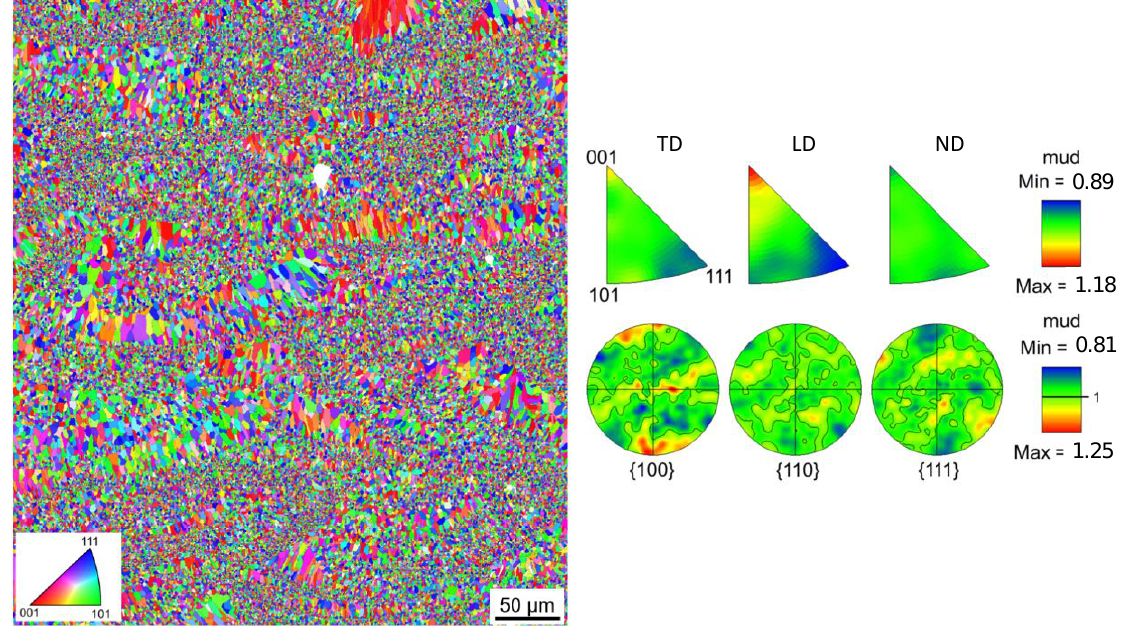
Figure 6. EBSD micrograph in longitudinal direction (or building direction) and inverse pole figures of the as-built LPBF specimen manufactured with the powder mixture.